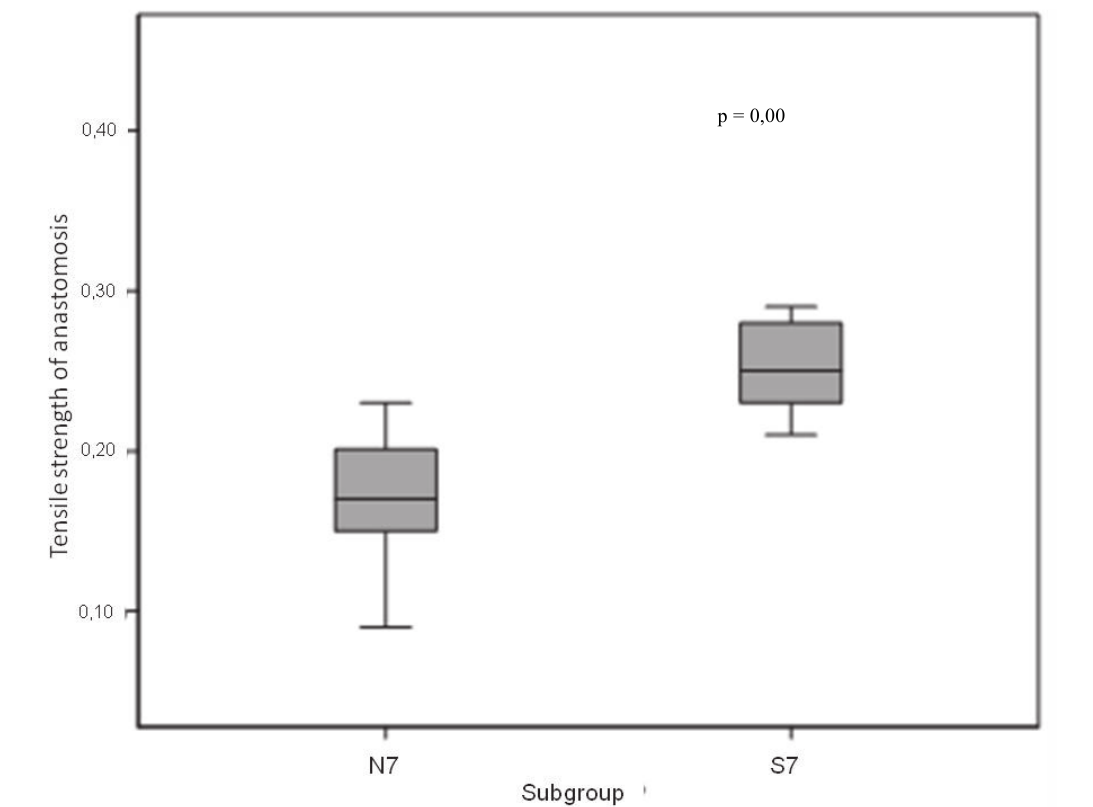
FIGURE 3 - Median and interval values for bursting strength in the anastomosis of subjects which underwent euthanasia on the seventh post-operatory